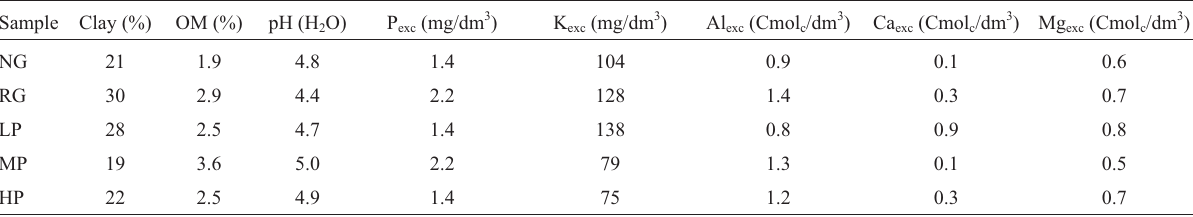
Table 1 - Soil chemical properties under different grazing